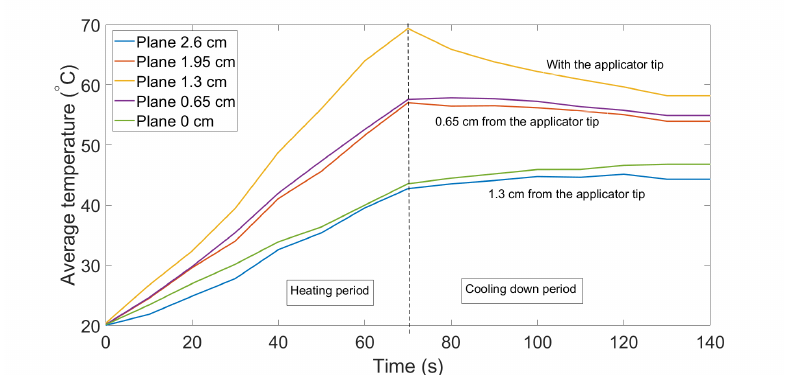
Figure 6. Change in the average temperature on the five cross-sections of the tissue along the y-axis: trial